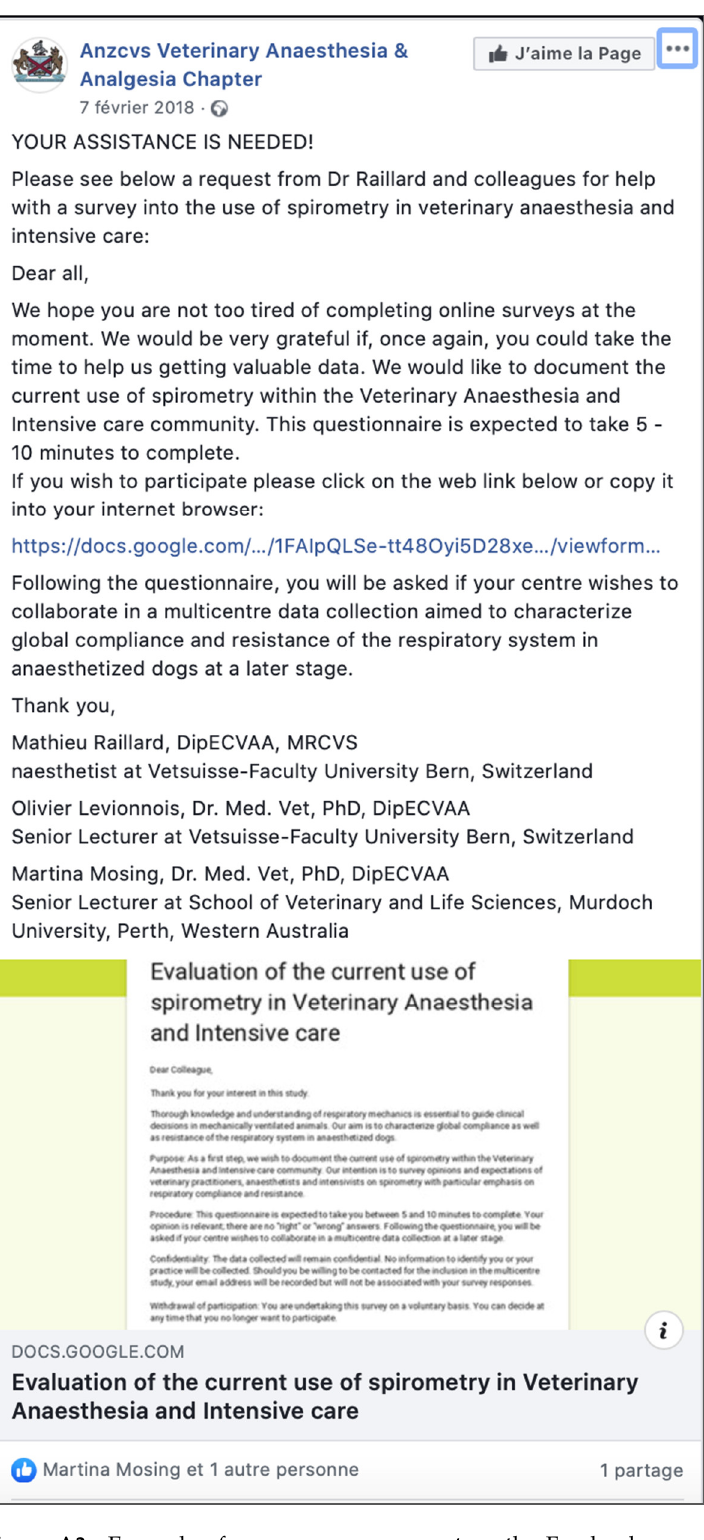
Figure A3. Example of survey announcement on the Facebook page of the Anzcvs Veterinary Anaesthesia & Analgesia Chapter.